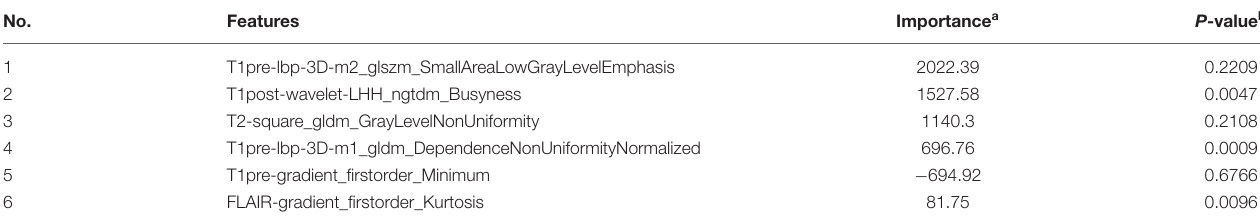
TABLE 5 | Six features used to predict CIC mutation in oligodendrogliomas.